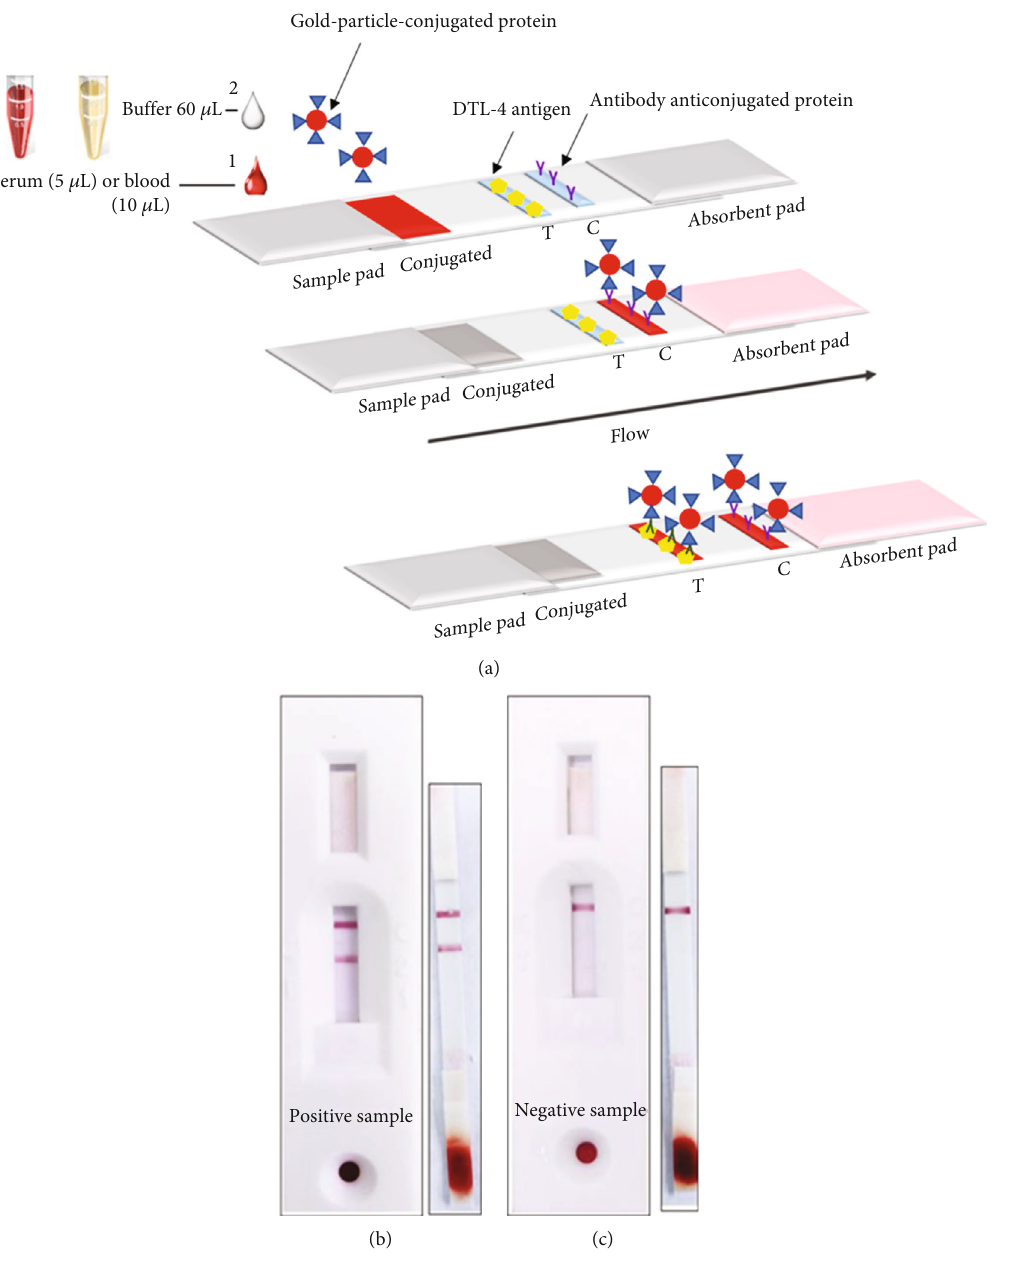
Figure 3: Representation of the ICT to detect IgG anti- Leishmania antibody. (a) The rapid test scheme developed for the detection of IgG anti- L. infantum . (b) Positive sample and (c) negative